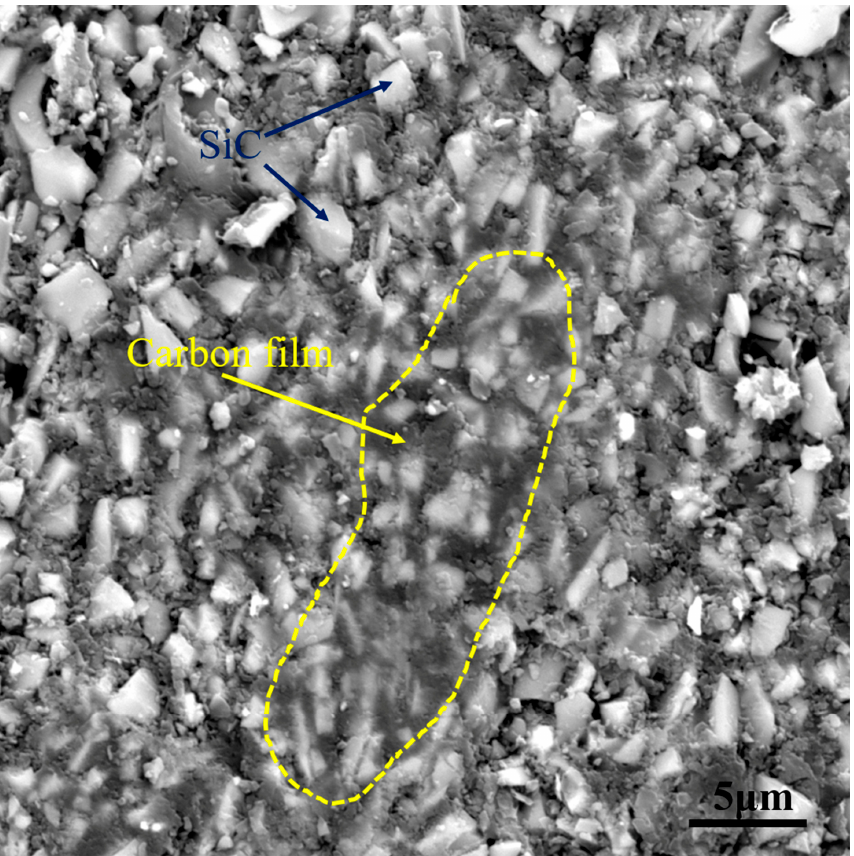
Figure 6. The microstructure of PF-100.